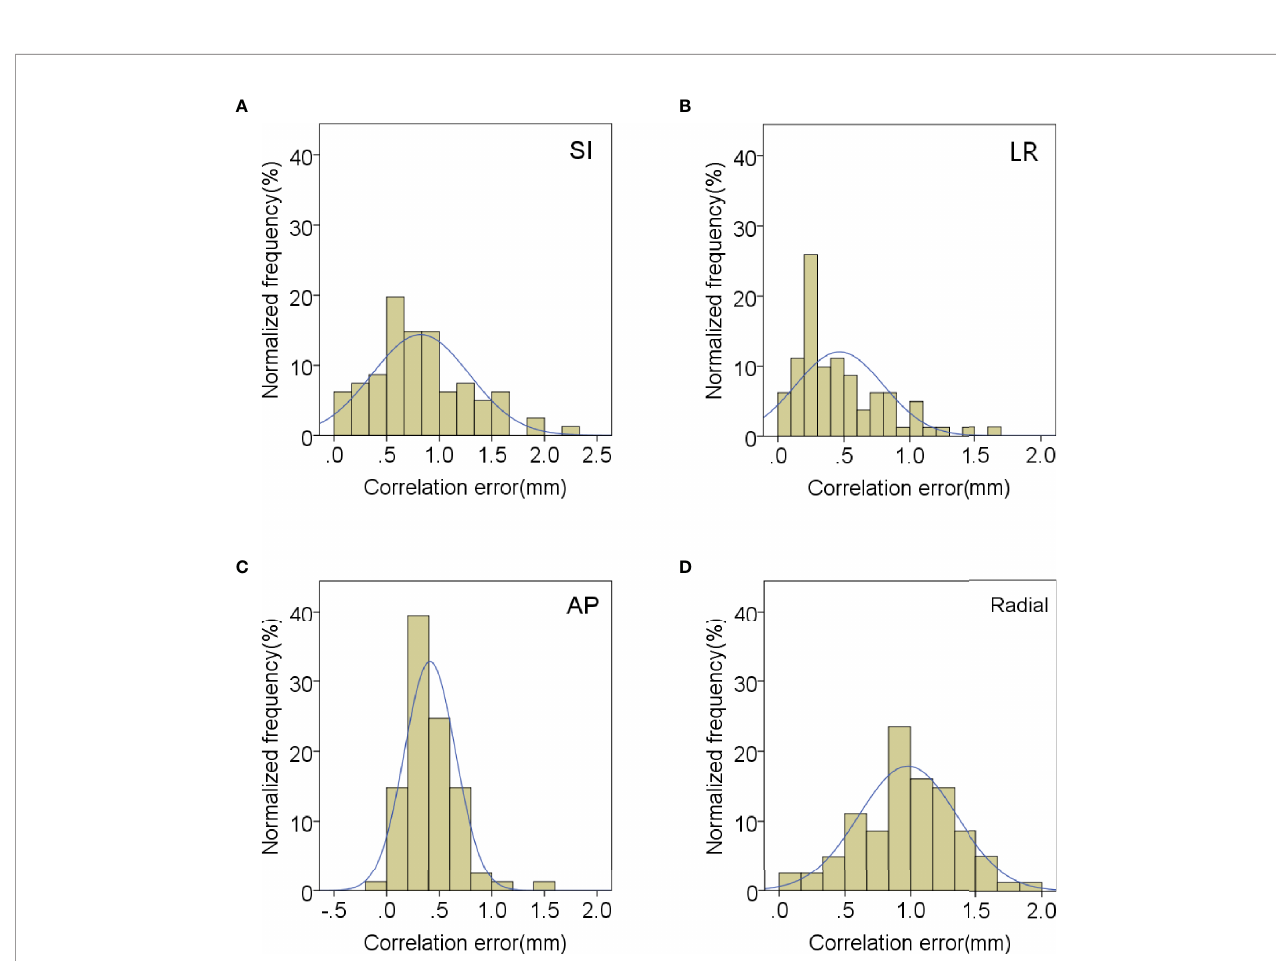
FIGURE 1 | Distribution of mean correlation errors in (A) SI, (B) LR, (C) AP and (D) radial directions.